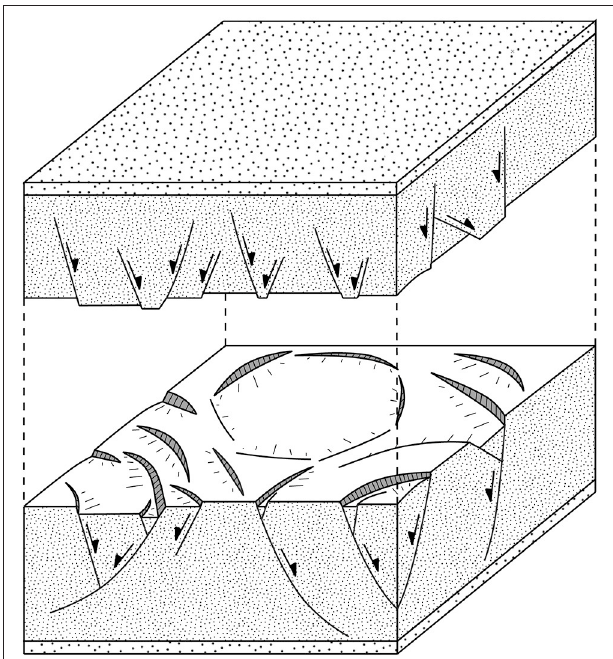
FIGURE 1 | Schematic diagram of a polygonal fault system comprised of a large numbers of layer-bound, low-displacement ( < 100m throw) normal faults, which have a more-or-less polygonal arrangement in